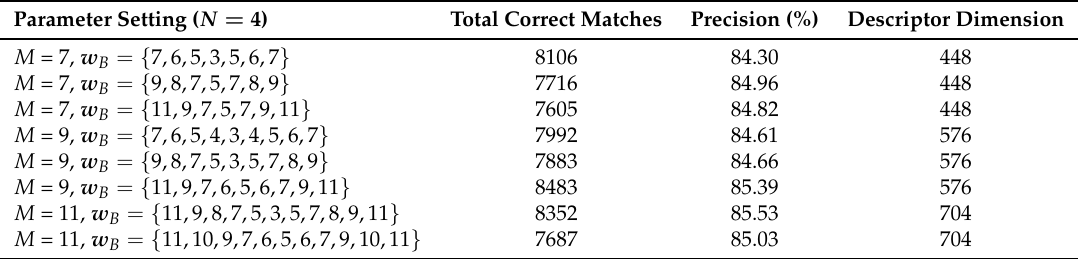
Table 2. Experimental Results with different parameters ( M , w B